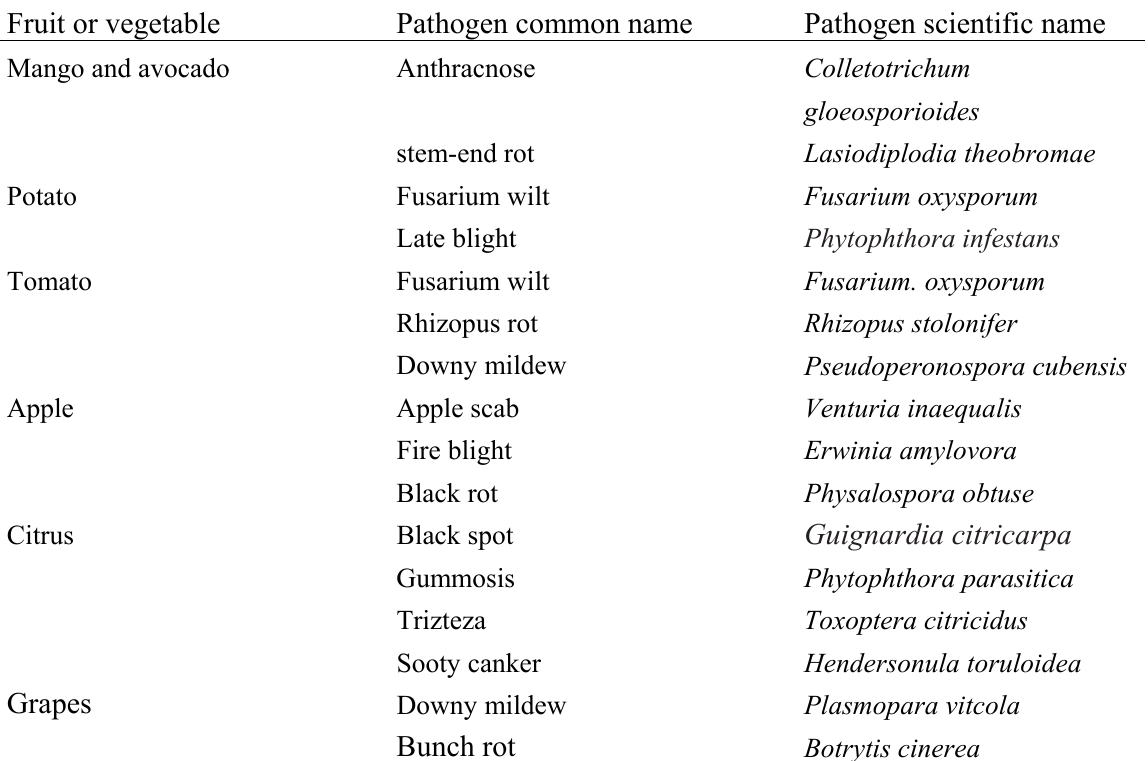
Table 1. Pathogens attacking selected fruits and